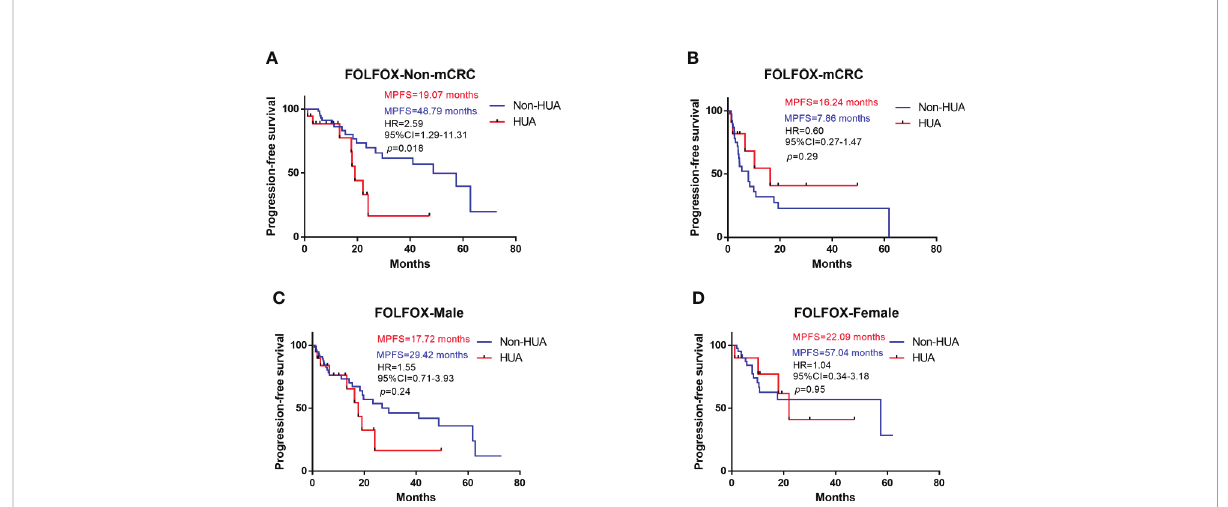
FIGURE 2 Subgroup analysis for PFS of patients treated with FOLFOX. HUA, high uric acid, Non-HUA, non-high uric acid, MPFS, median PFS. (A) PFS of the non-mCRC patients treated with FOLFOX. (B) PFS of the mCRC patients treated with FOLFOX. (C) PFS of male CRC patients treated with FOLFOX. (D) PFS of female CRC patients treated with FOLFOX.